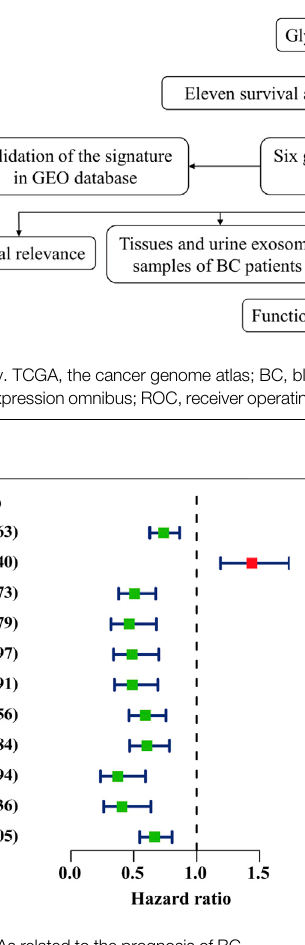
FIGURE 2 | The selected glyco-lncRNAs related to the prognosis of BC patients. The lncRNAs with red front were involved in construct the prediction